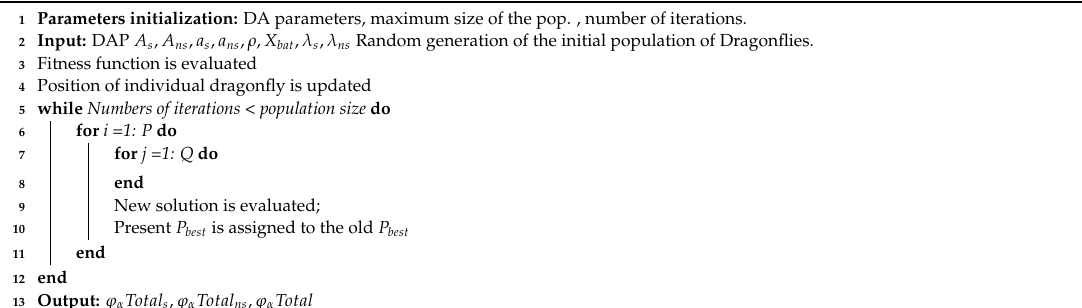
Algorithm 1: Pseudocode of the proposed Dragonfly Algorithm